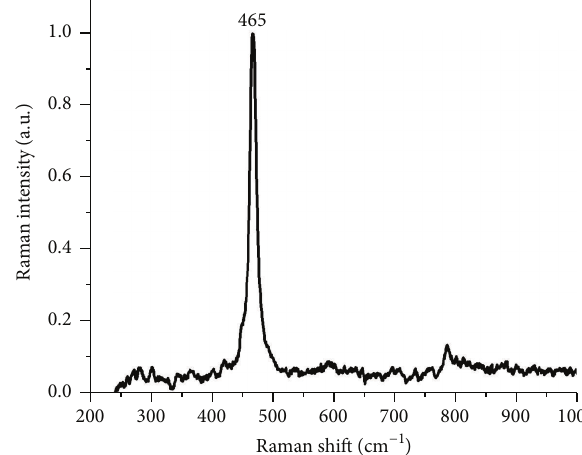
Figure 14: Results of Raman spectroscopy for SrAl 2 O 4 NPs excited at 514 nm laser wavelength.